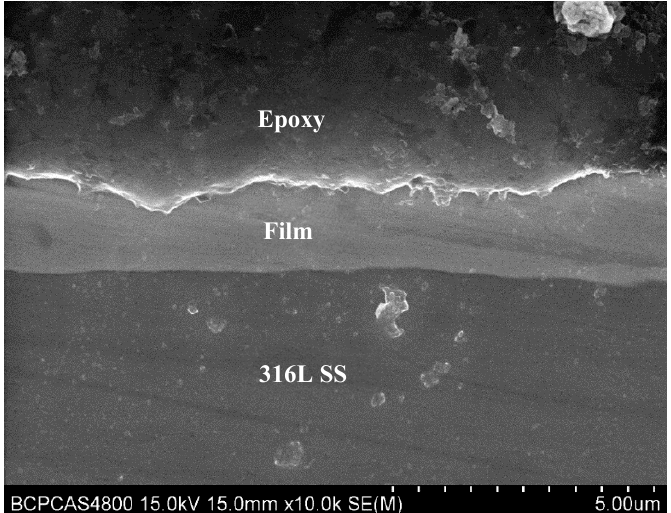
Figure 1. The cross section morphology of the Pd-Ni film.